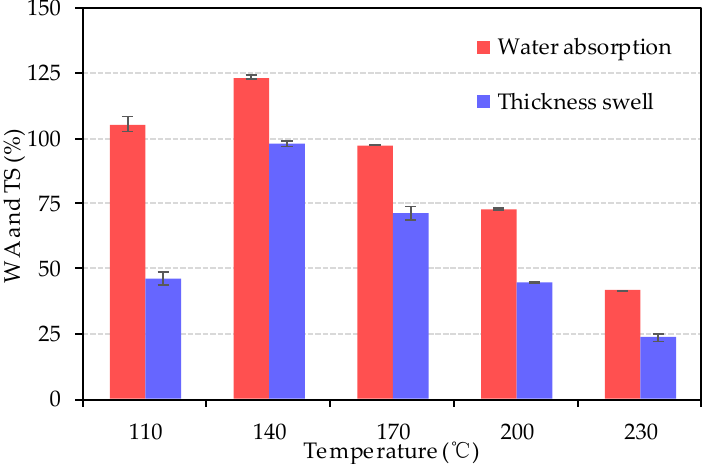
Figure 13. The WA and TS of bio-board at di ff erent temperatures ( p < 0.05).